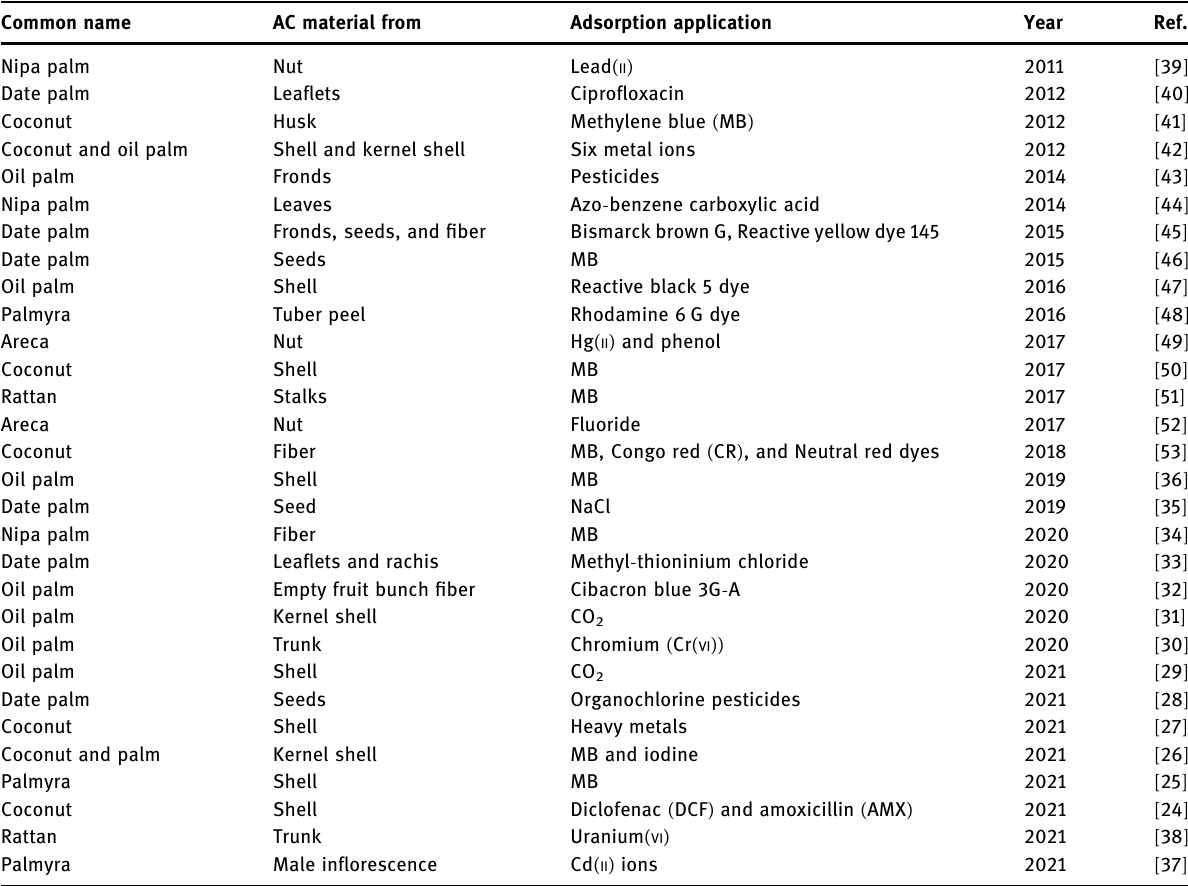
Table 1 : Research statistics on Arecaceae family trees Common